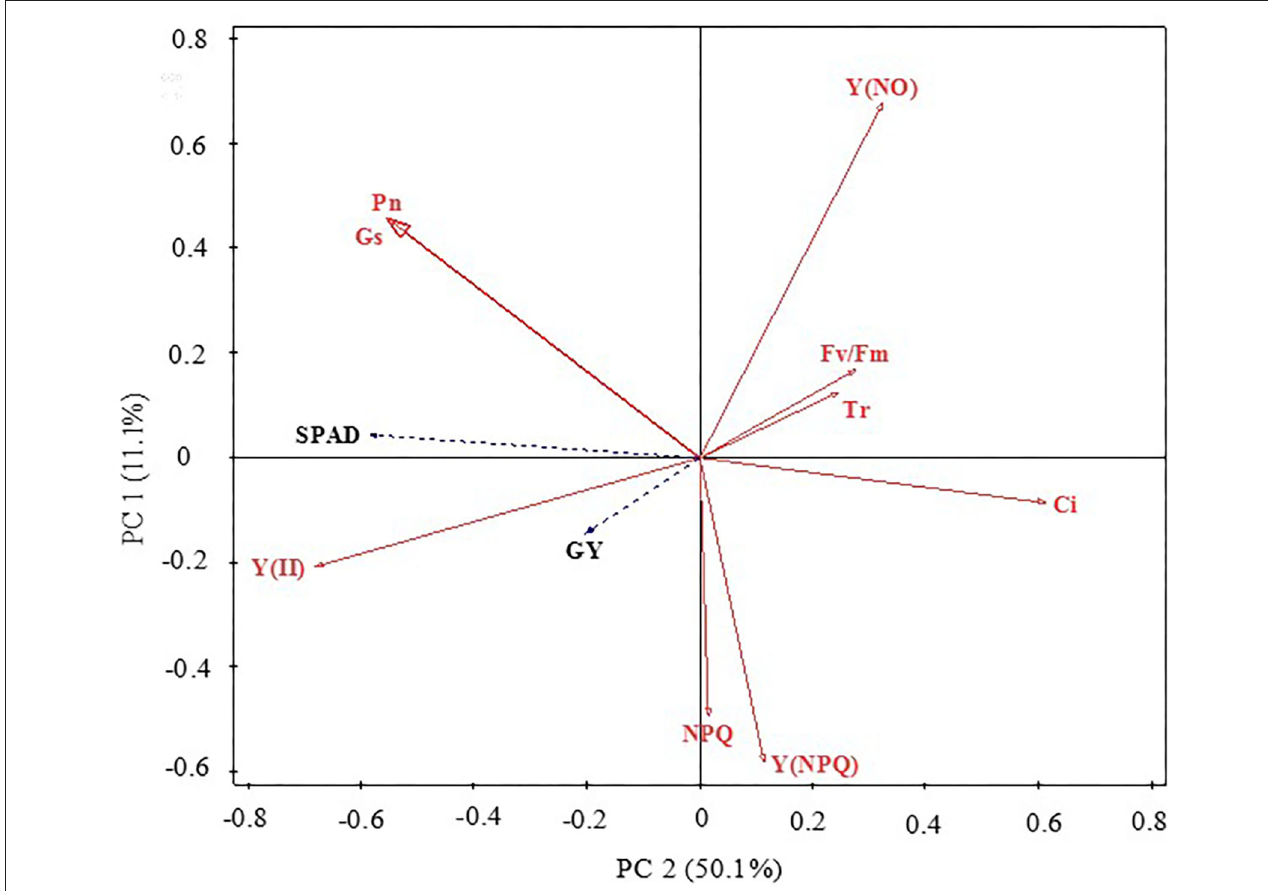
FIGURE 3 | Principal component analysis of maize grain yield, leaf chlorophyll contents (SPAD), gas exchange, and chlorophyll fluorescence parameters. GY, grain yield; SPAD, relative content of chlorophyll; Pn, photosynthetic rate; Gs, stomatal conductance; Tr, transpiration rate; Ci, intercellular CO 2 concentration; Fv/Fm, maximal photochemical efficiency of PSII; Y(II), actual photochemical efficiency of PSII; NPQ, dissipation of excess energy; Y(NPQ), quantum yield of regulated non-photochemical energy loss; Y(NO), quantum yield of non-regulated non-photochemical energy